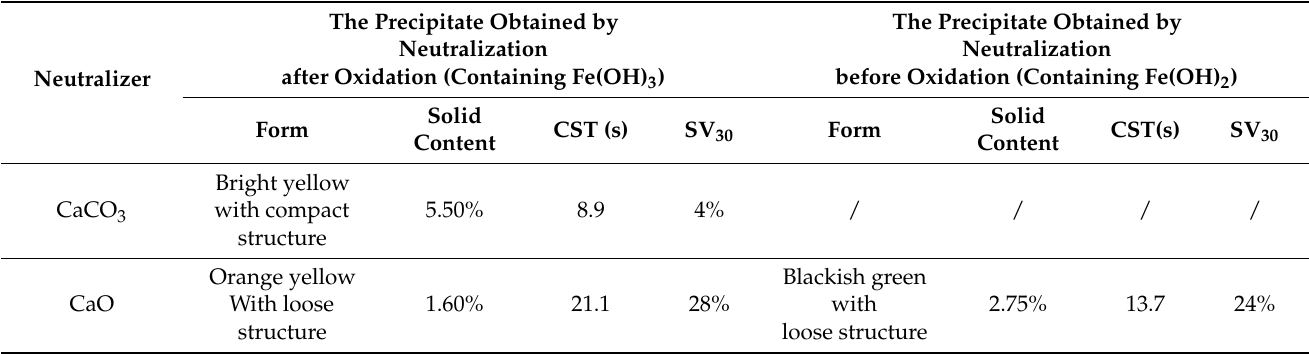
Table 2. Analysis of the difference of the precipitates obtained under different